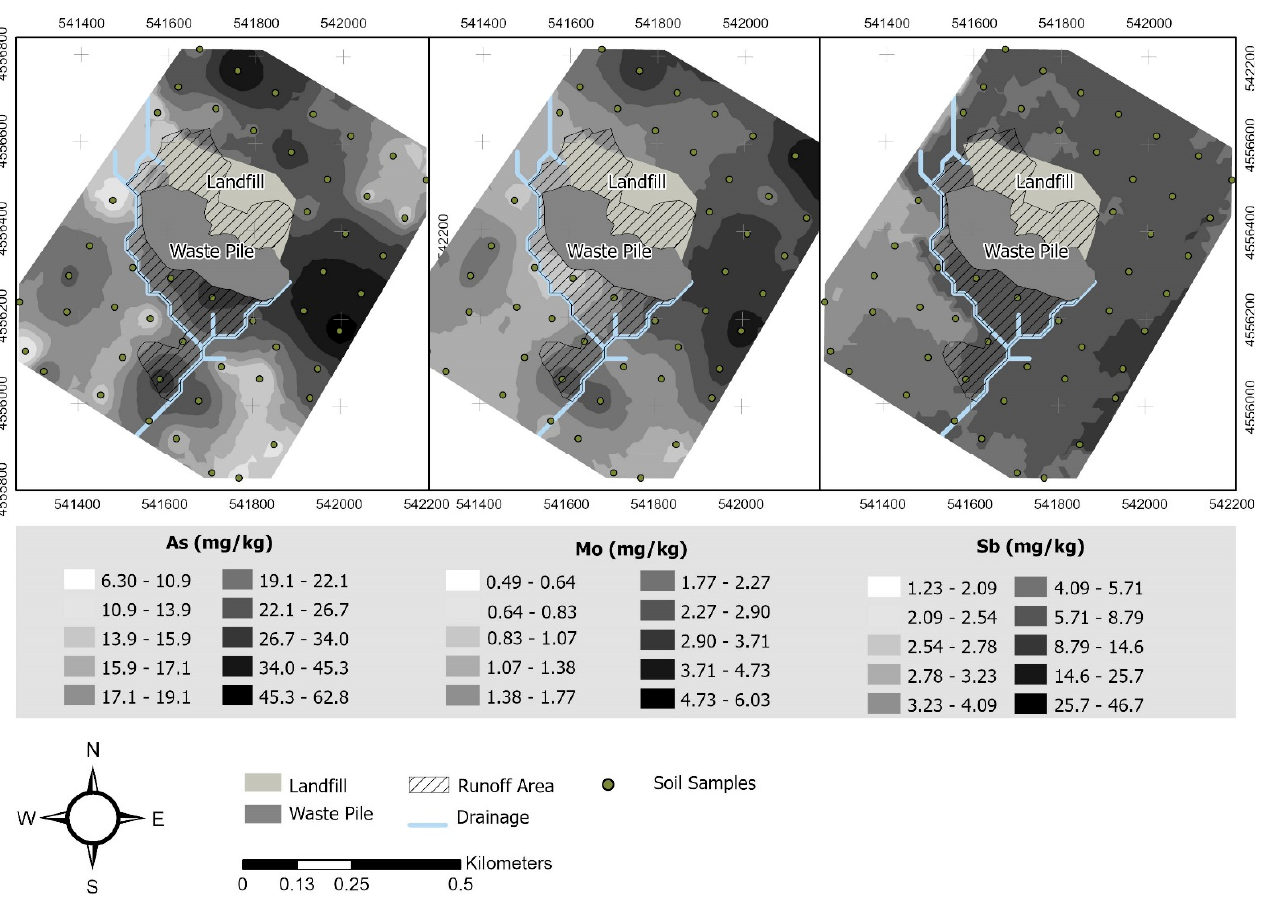
Figure 8. Spatial distribution of As, Mo, and Sb in the soils that surround the São Pedro da Cova waste pile, interpolated by ordinary kriging.